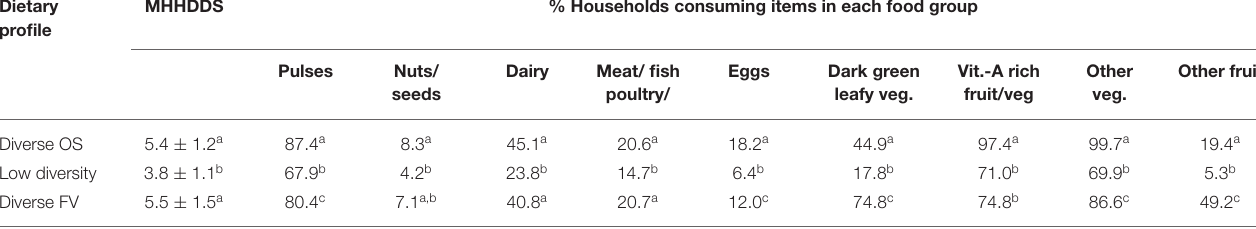
TABLE 1 | The mean Modified Household Dietary Diversity Score (MHHDDS ± SE) and the percentage of households that consumed each food group of the households following each dietary profile. Dietary profile